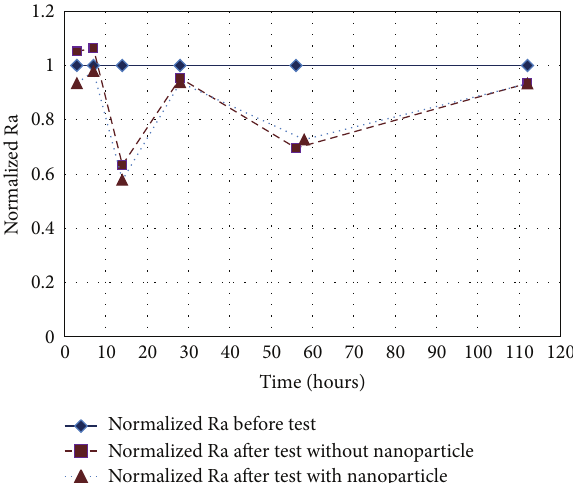
Figure 7: Normalized Ra roughness for alloy 110 copper before and after 3-, 7-, 14-, 28-, 56-, and 112-hour treatments with the reference fluid of 50/50% ehtylene glycol in water and with nanofluid of 2% nanoalumina in reference